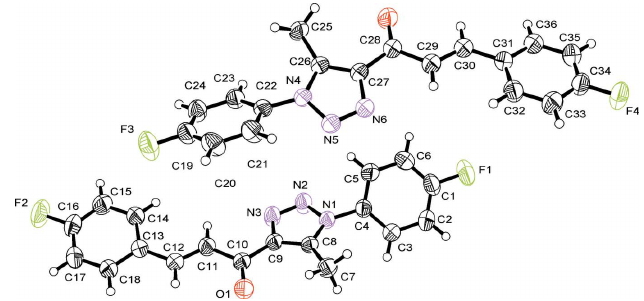
Figure 1 An ORTEP representation of the two unique molecules showing 50% probability ellipsoids.